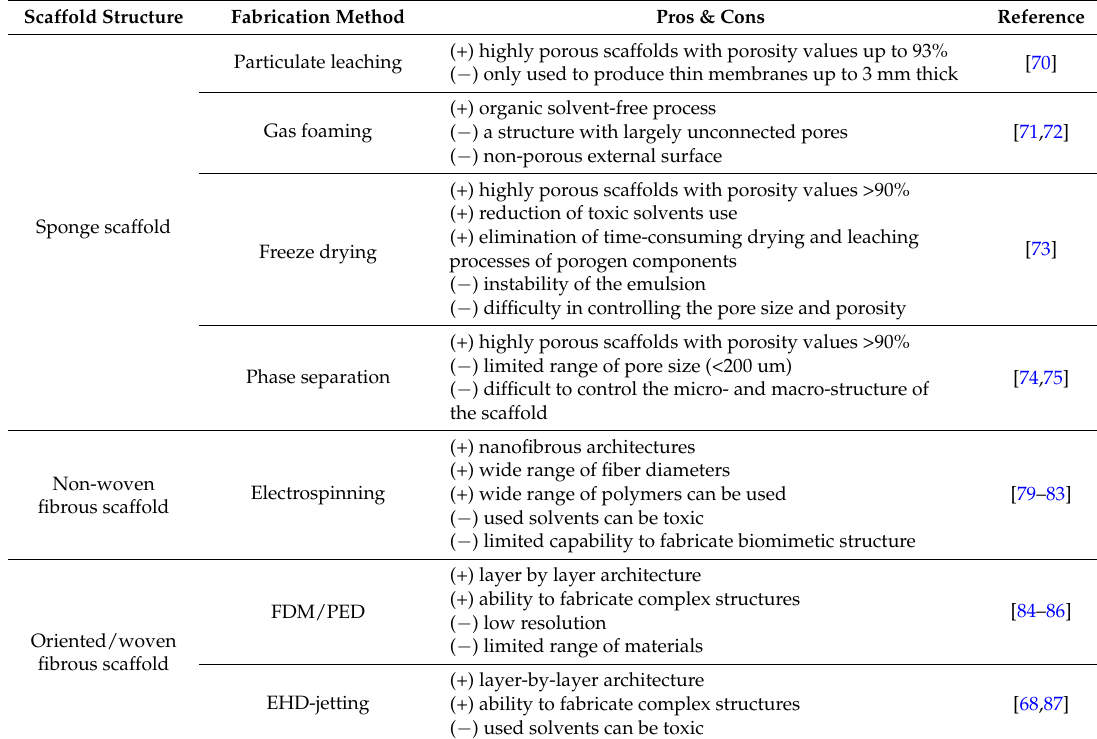
Table 2. Common fabrication technologies used in meniscal tissue